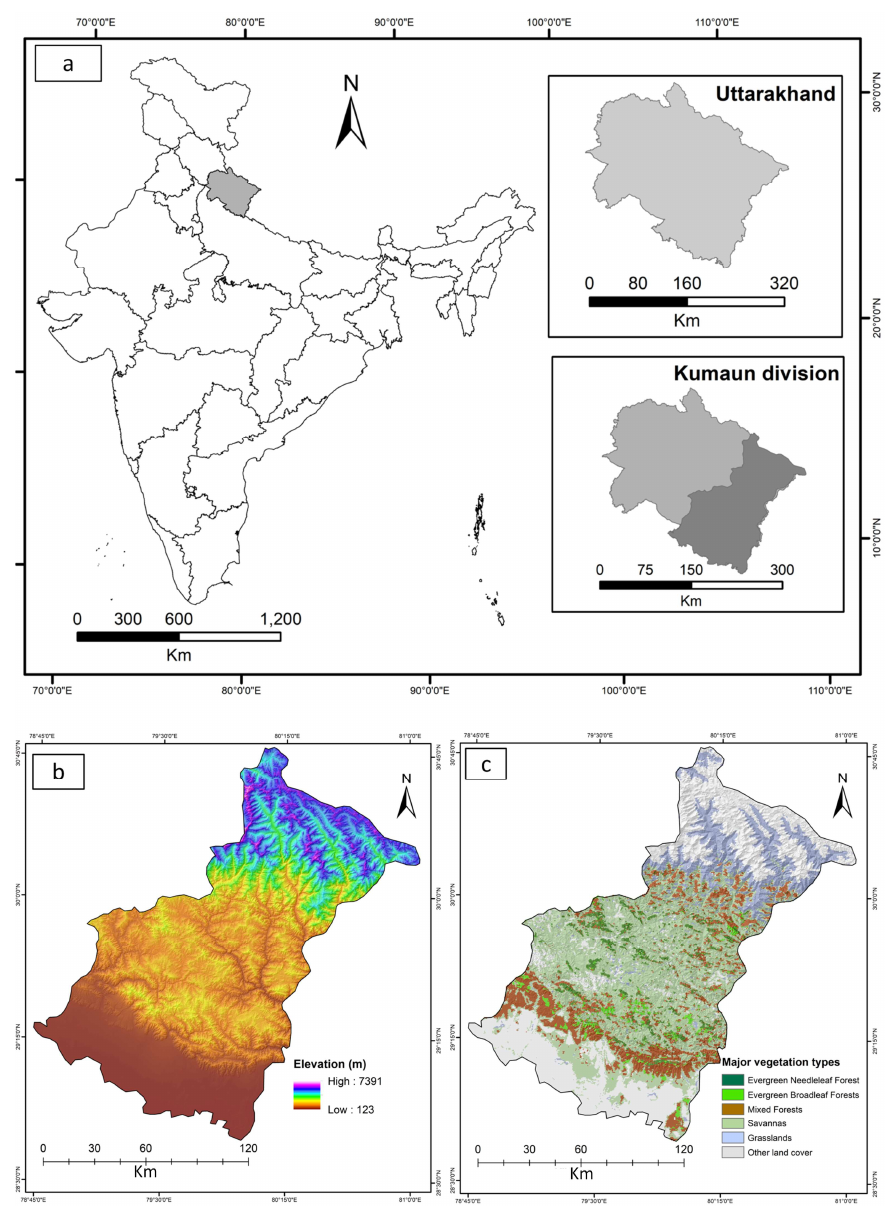
Figure 1. ( a ). Study area location, ( b ) elevation gradient, and ( c ) major vegetation type